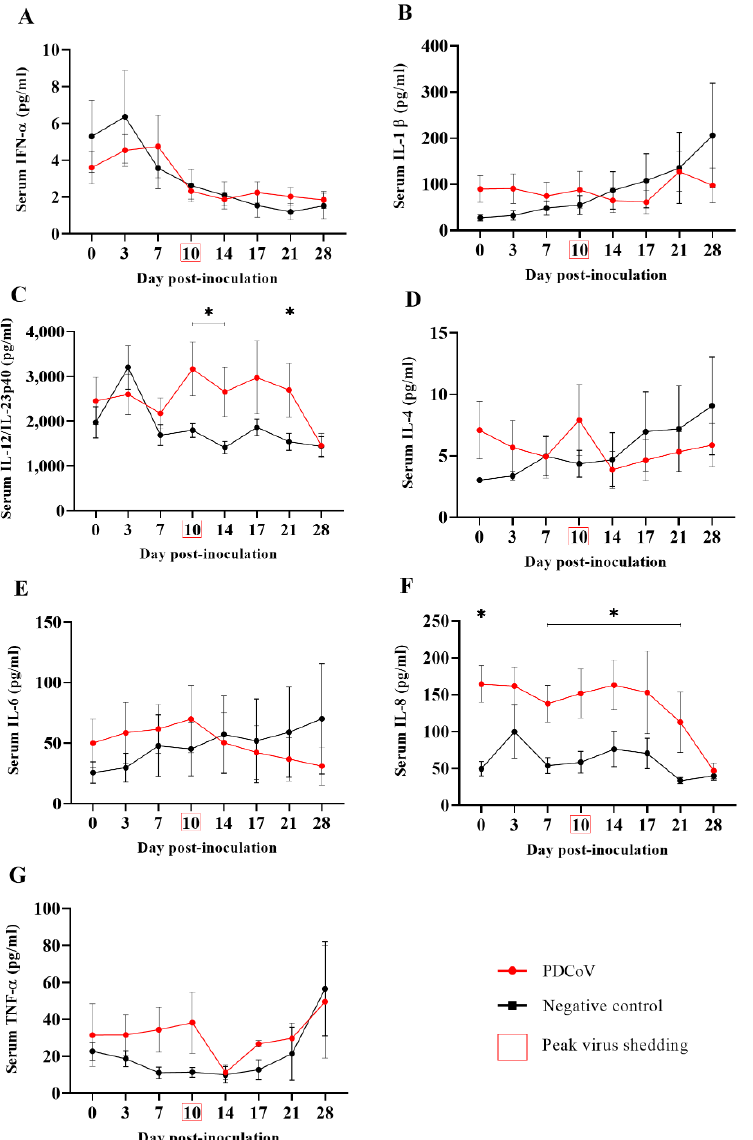
Figure 4. Serum cytokine/chemokine levels (ng/mL; y -axis) of IFN- α ( A ), IL-1 β ( B ), IL-12/IL-23p40 ( C ), IL-4 ( D ), IL-6 ( E ), IL-8 ( F ), and TNF- α ( G ) over time ( x -axis) in 7-week-old pigs ( n = 12) experimentally inoculated with PDCoV, compared to corresponding mock-inoculated pigs ( n = 12). Serum samples were collected at 0, 3, 7, 10, 14, 17, 21, and 28 days post-inoculation (DPI). Graphs were generated from data collected via multiplex Luminex assay testing (ProcartaPlex™ Panel from Invitrogen). IFN- γ and IL -10 were not detected at any time point and hence were not plotted. The minimum detectable levels for each cytokine/chemokine evaluated were: 0.87 pg/mL (IFN- α), 2.66 pg/mL (IL- 1β), 48 pg/mL (IL -12/IL-23p40), 1.56 pg/mL (IL-4), 6.84 pg/mL (IL-6), 4.66 pg/mL (IL-8), 5.86 pg/mL (TNF- α), 4.96 pg/mL (IFNγ), and 4.76 pg/mL (IL -10). Error bars represent the standard error of the mean (SEM), and * denotes statistical differences ( p < 0.05).